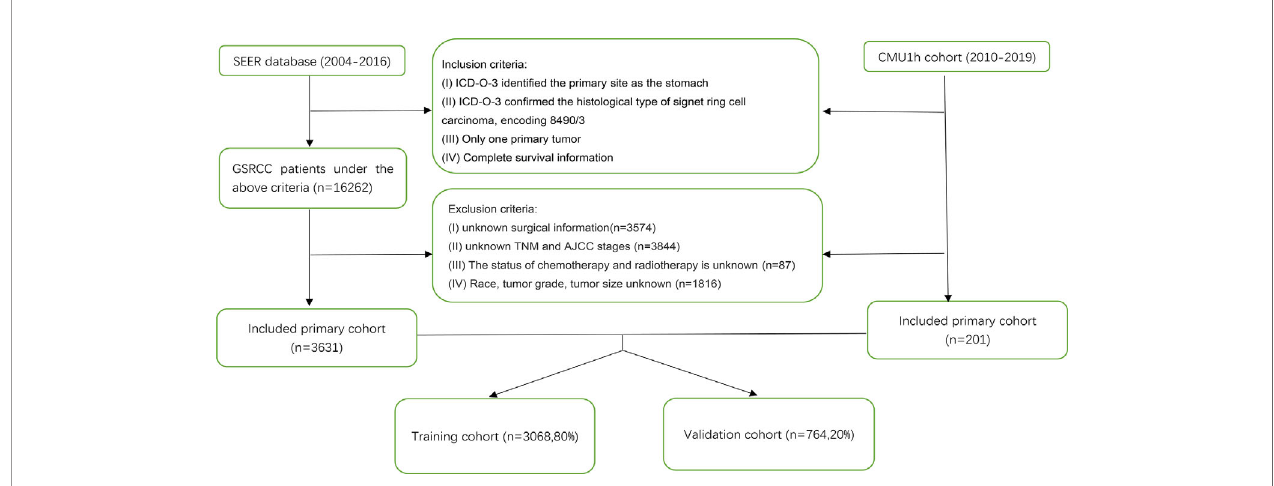
FIGURE 1 | Flowchart of patients identi fi ed in this